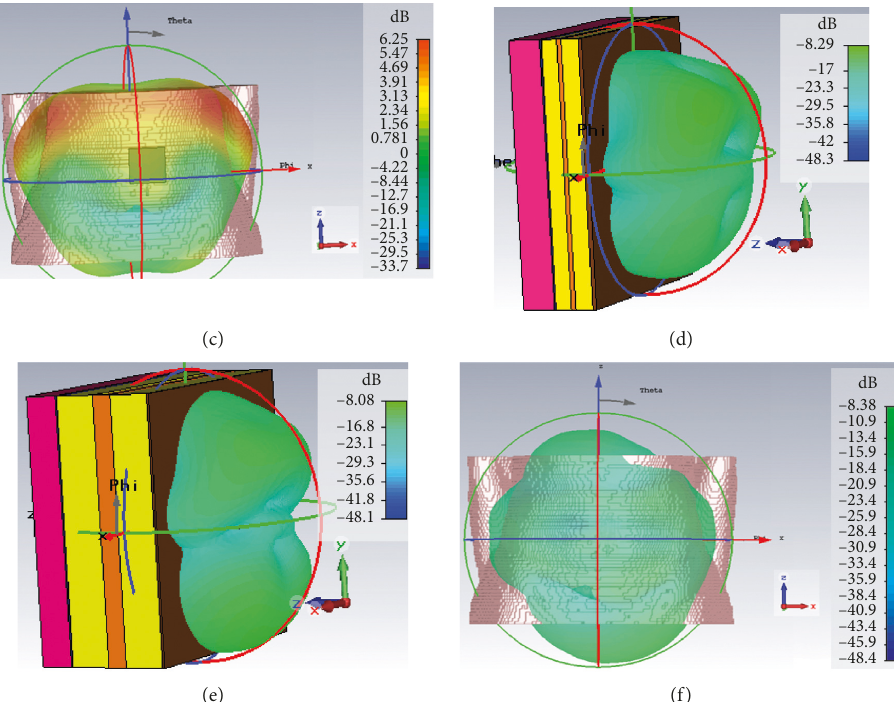
Figure 18: 3D realized gain of the proposed reflector-backed antenna next to the multilayer model for (a) PA at 30mm, (b) PE at 30 mm, (c) the voxel model at 30mm, (d) PA at 4mm, (e) PE at 4 mm, and (f) the voxel model at 4